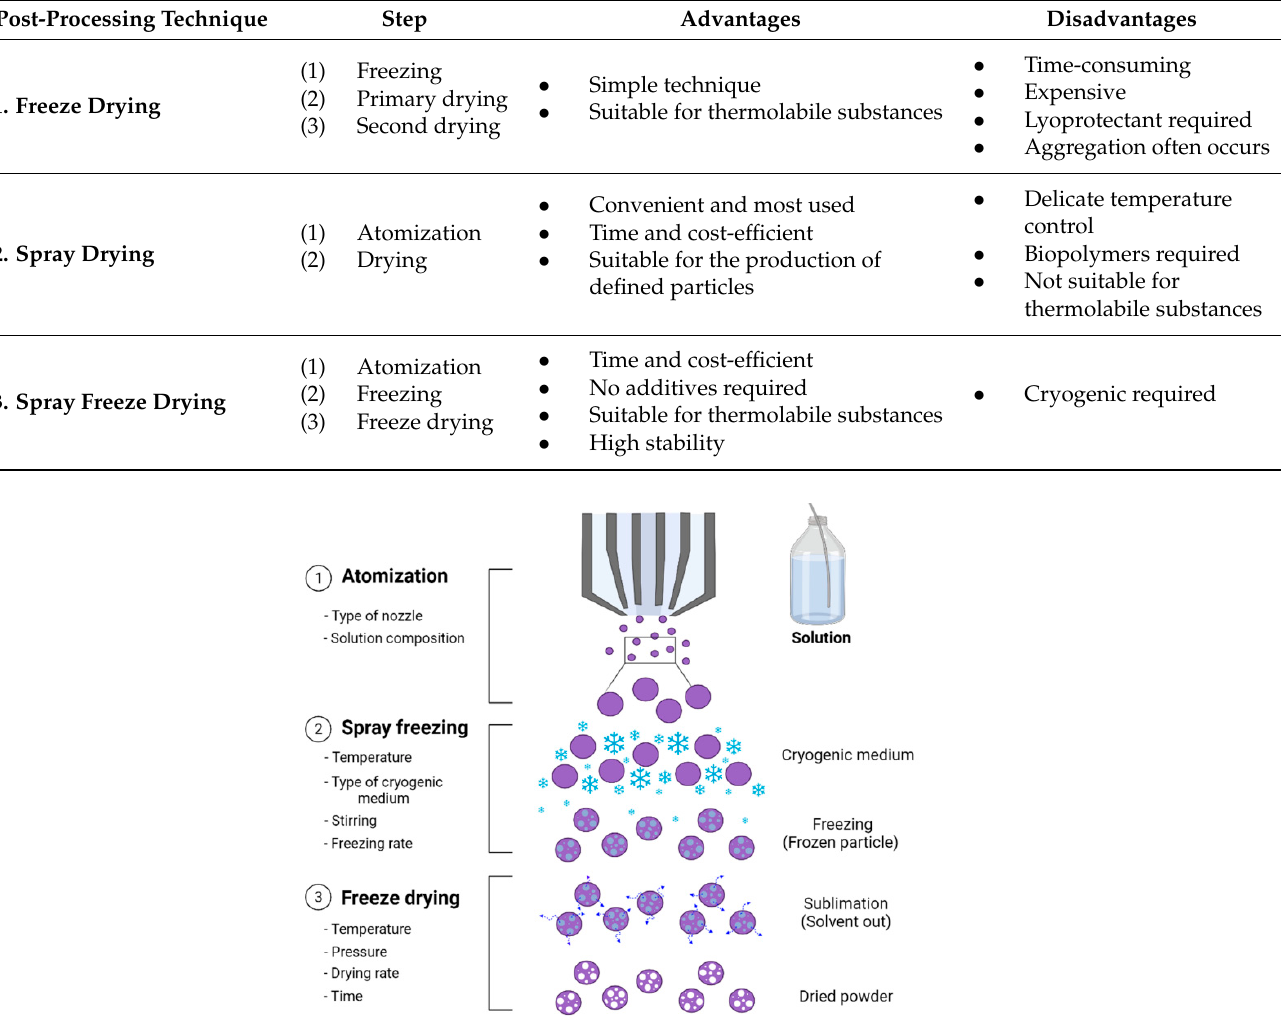
Figure 4. Illustration showing the steps involved in typical spray freeze drying. Adapted with permission from ref. [1]. 2021,